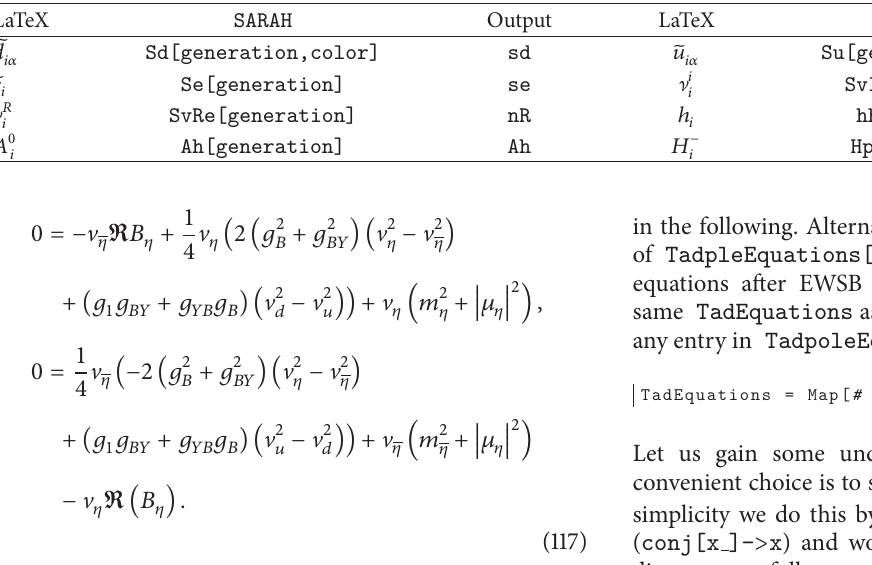
Table 3: Scalars in the B-L- SSM after electroweak symmetry